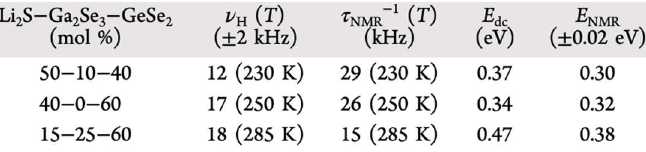
Figure 5. EIS and NMR-derived ion jump frequencies and activation energies for three LGGS glasses. [16]